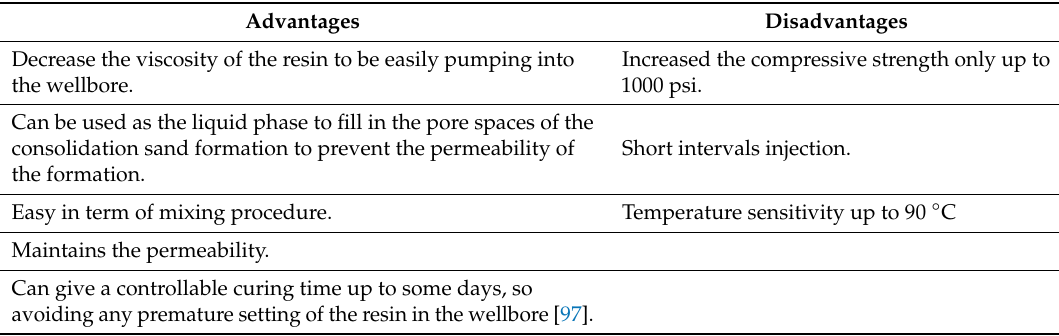
Table 17. Permeability enhancing additive (PEA) method to consolidate sand formation.